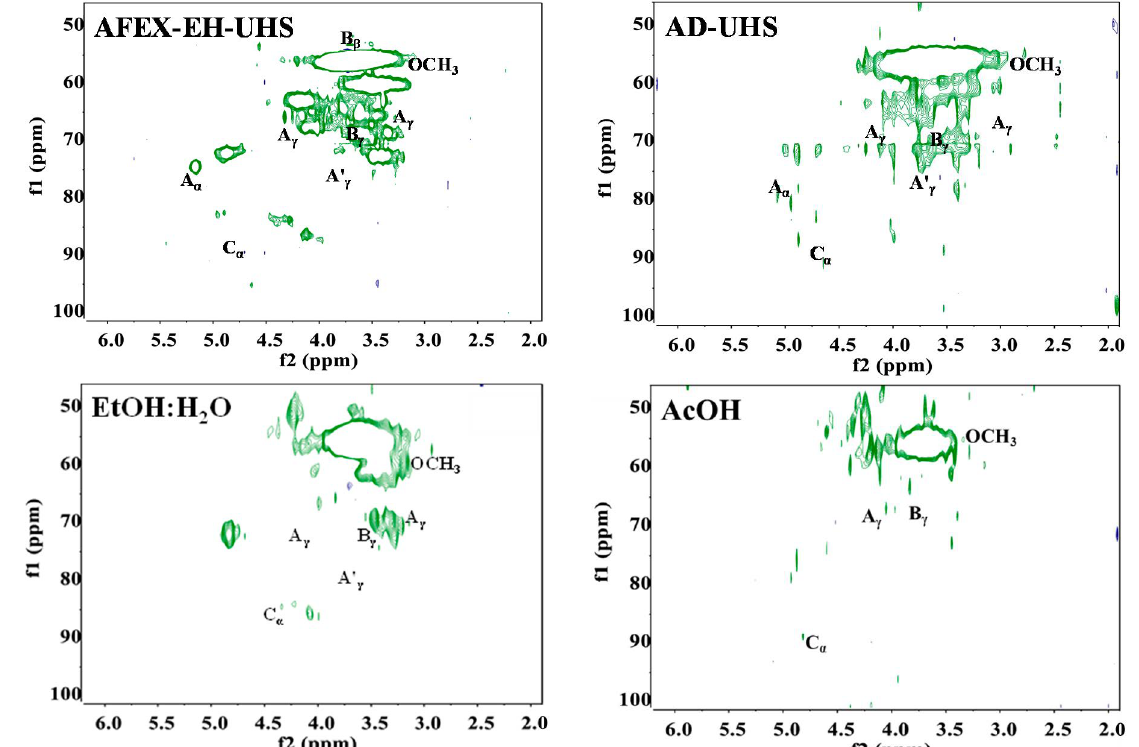
Figure 3. Aromatic region of the 2D-HSQC NMR spectra of material extracted from AD-UHS with different solvents, and standard lignin of AFEX-EH-UHS and AD-UHS.